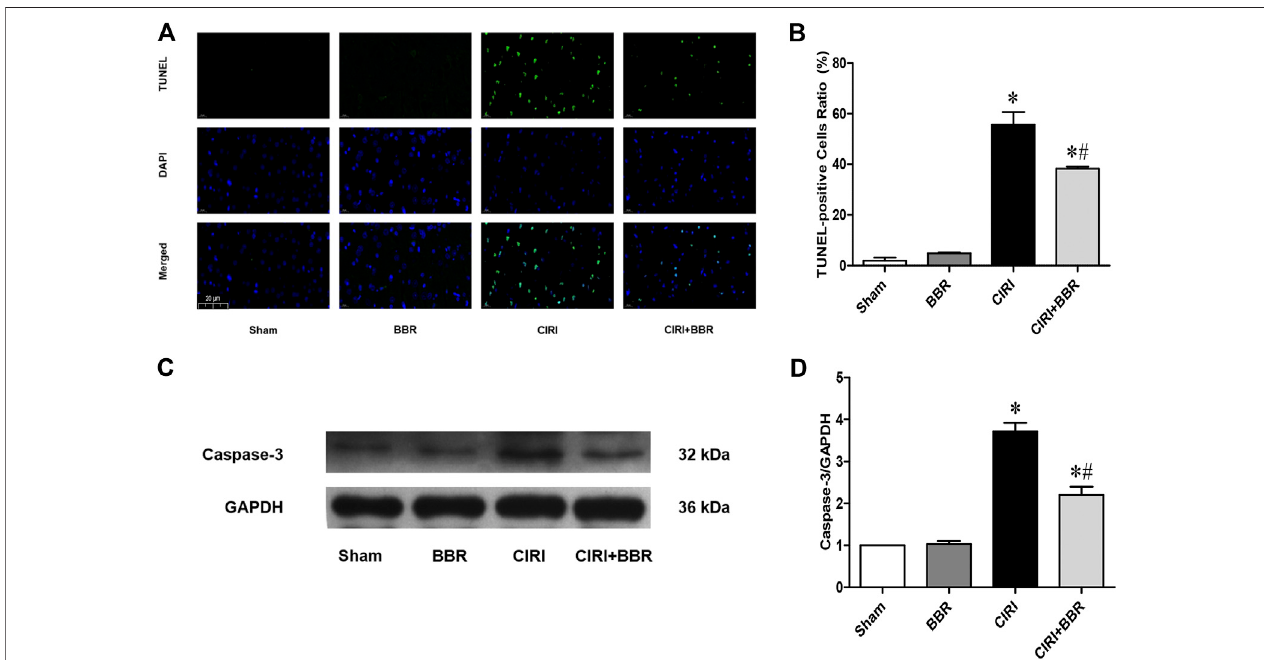
FIGURE 2 | BBR attenuates neuronal apoptosis in ischemic penumbra induced by CIRI. (A) , TUNEL staining was performed on slices from cortical ischemic penumbra. (B) ,Ratioofpositivecells.Originalmagni fi cationis400 × ,scalebarsis20 μ m. (C) ,TheapoptoticproteincleavedCaspase-3fromcorticalischemicpenumbra was determined by Western blot. GAPDH was used as the loading control. n (cid:2) 6. (D) Bar graph showing the statistical comparison of Caspase-3 protein levels across groups. Data are shown as the mean ± SEM. * p < 0.05 compared with Sham group; # p < 0.05 compared with the CIRI group.